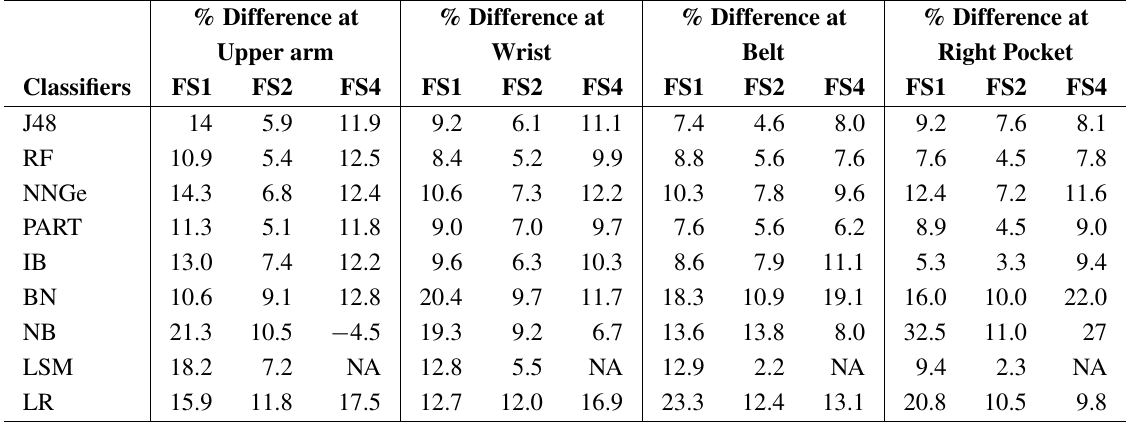
Table A.5. Performance difference (AG—max(A,G)) for the walking downstairs activity in Scenario A. % Difference at % Difference at % Difference at Upper arm Wrist Belt Right Pocket